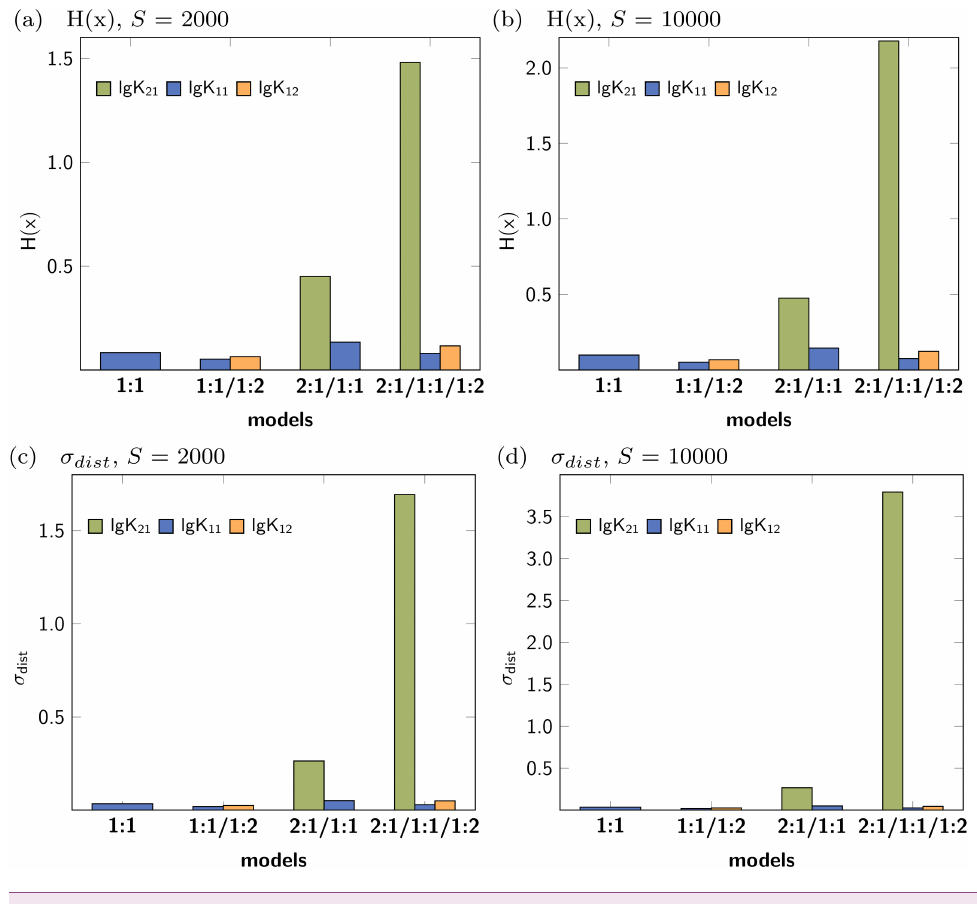
Figure 3 Calculated Shannon entropy (H(x)) and standard deviation ( σ dist ) of the individual stability constants after Monte Carlo simulations with S steps. The lowest values were obtained for the 1:1/1:2 model. Full-size DOI: